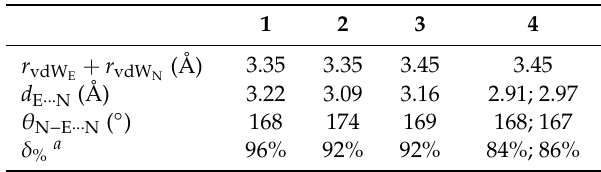
Figure 5. Arrangement of molecules in the crystal of 4 . Table 1. Comparison of the sums of van der Waals radii, length ( d ), valence angles ( θ ) and parameters δ % of ChBs occurring in the crystal structures of studied 1,2,5-chalcogenadiazoles (double values refer to two interactions differing in energy).